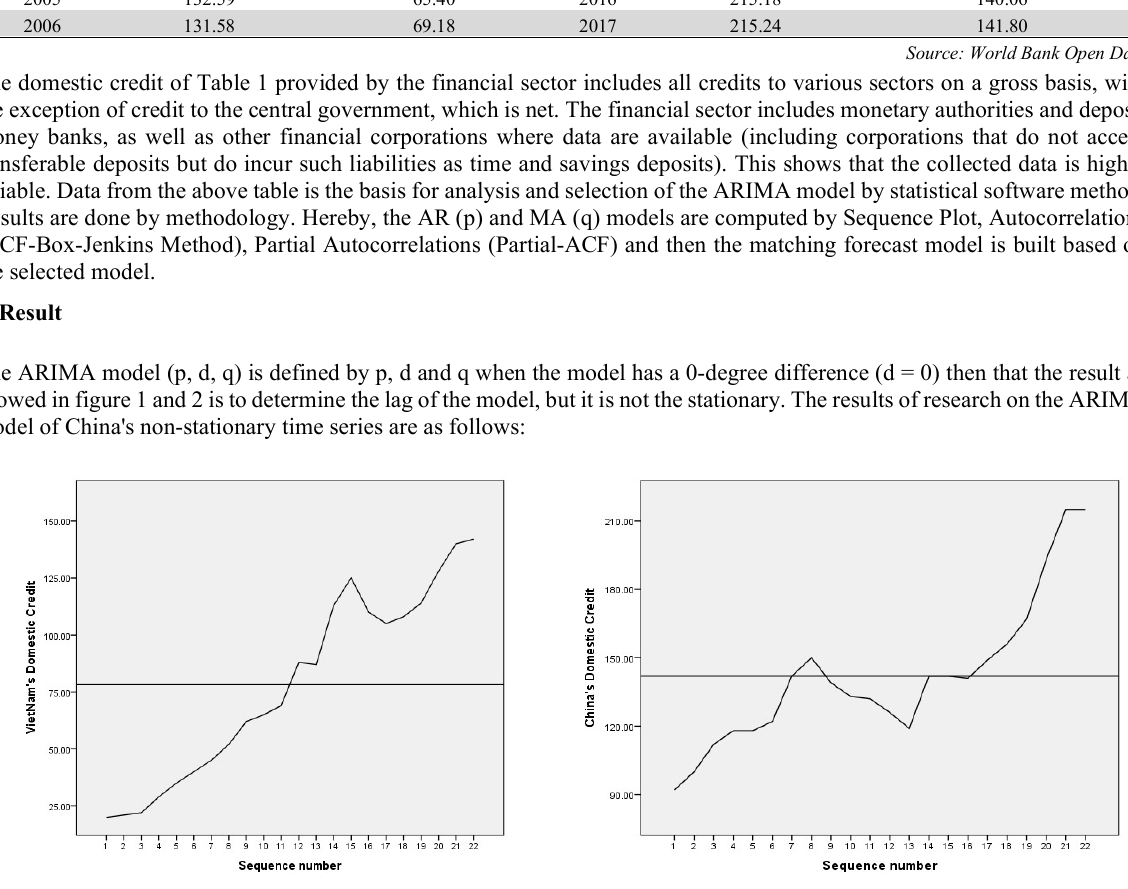
Fig. 1. Vietnam’s Domestic Credit: difference (d=0) Fig. 2. China’s Domestic Credit: difference